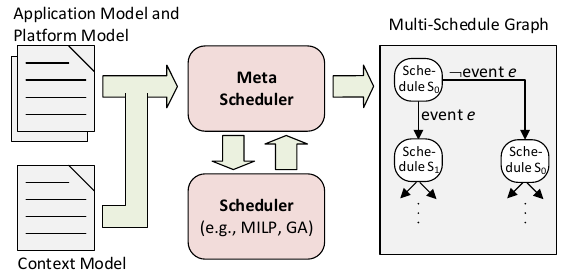
Figure 3. Meta scheduler